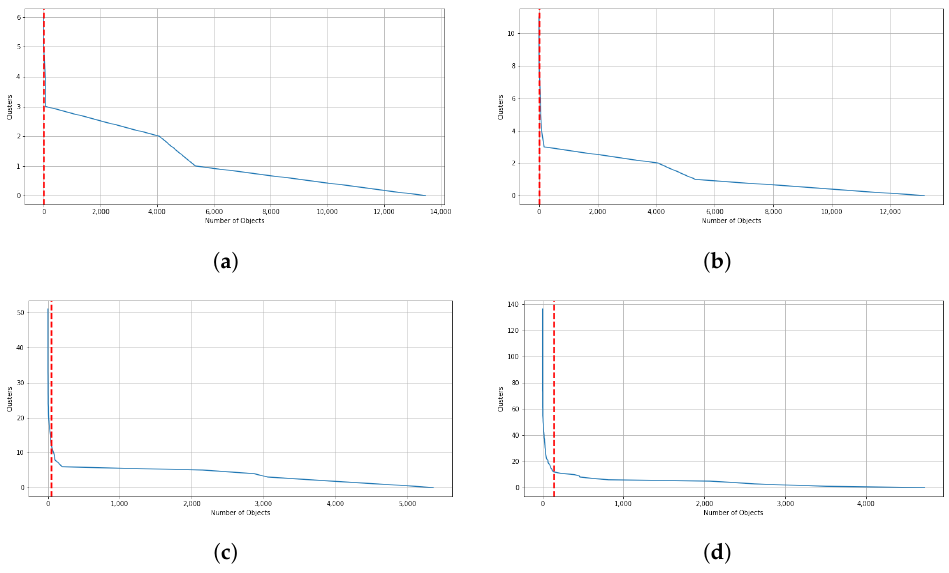
Figure 10. In this illustration, filtering values based on different consistency of cluster in ensemble clustering are demonstrated by red lines. ( a ) 80% consistency of clusters. ( b ) 85% consistency of clusters. ( c ) 94% consistency of clusters. ( d ) 98% consistency of clusters.